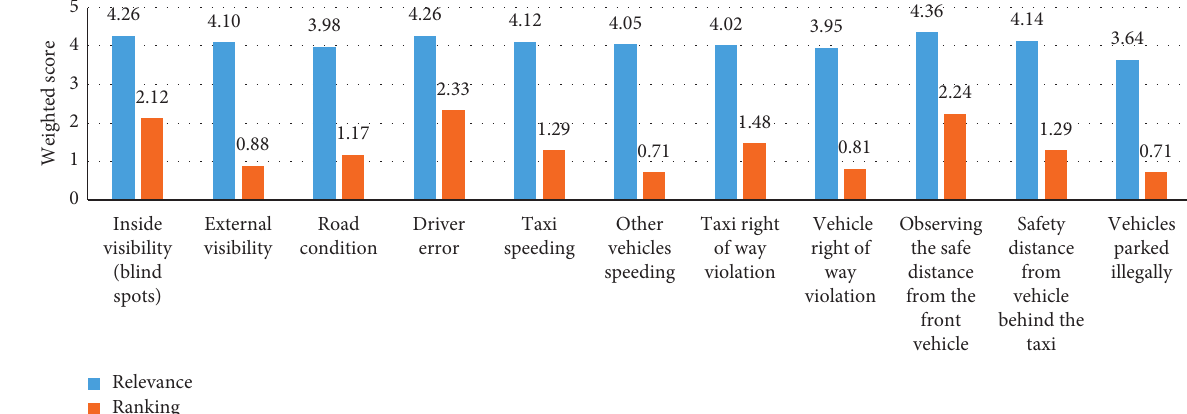
Figure 10: Weighted mean of relevance and priority ranking related to Question B2.